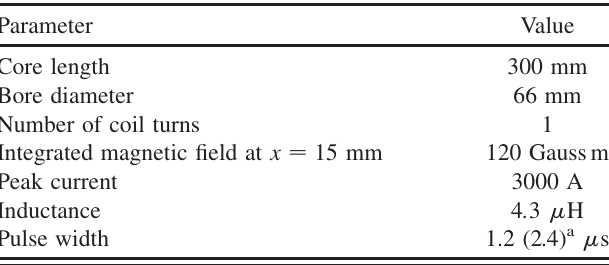
TABLE III. Main parameters of the PSM system. Parameter